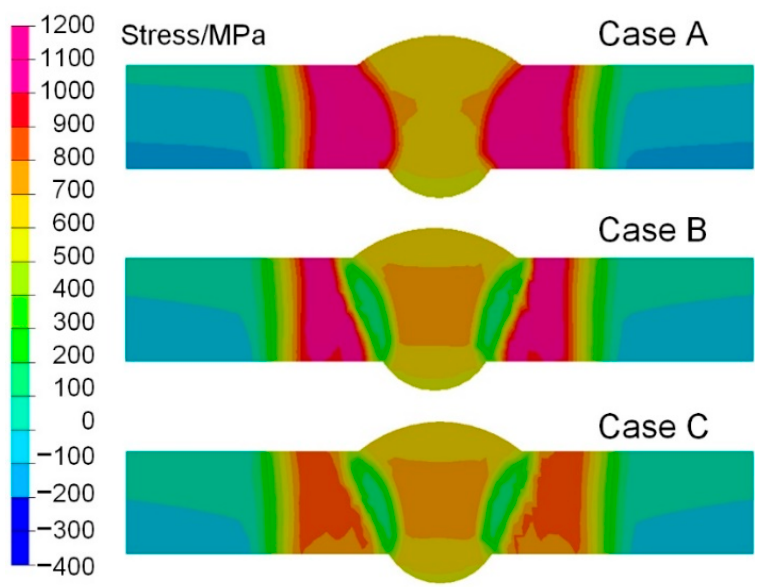
Figure 16. Longitudinal residual stresses distributions on central section of welded joint.